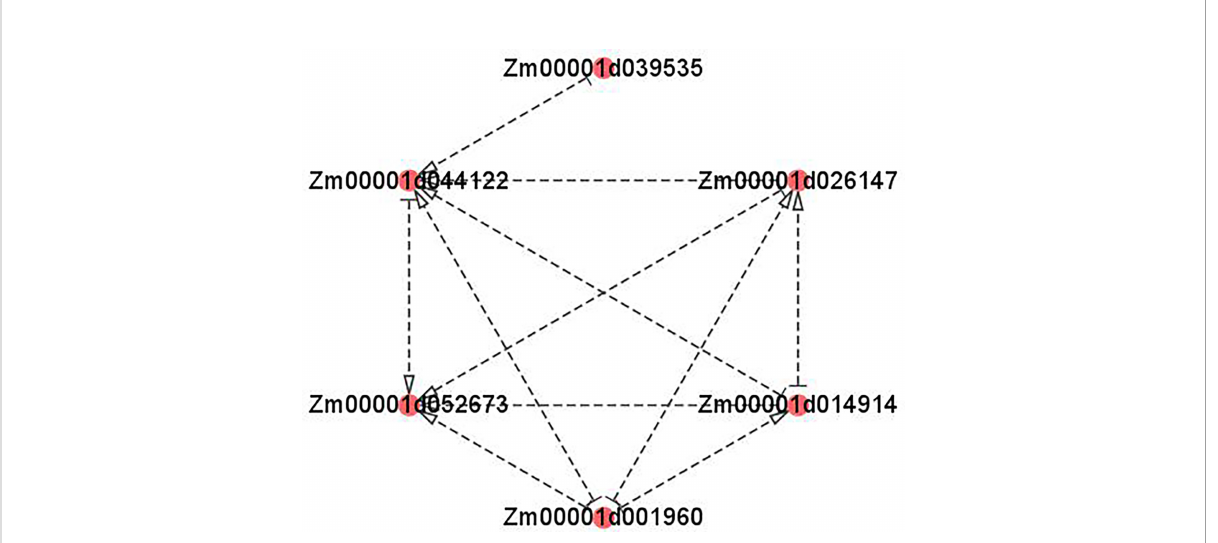
FIGURE 10 Visualization of co-expression gene network of hub genes by Cytoscape. The arrows pointed the target genes. And the other side of the arrows are the source genes. Zm00001d039535 : Acyl transferase 9 ( AcT9 ); Zm00001d044122 : Dihydro fl avonol 4-reductase ( DFR) ; Zm00001d052673 :